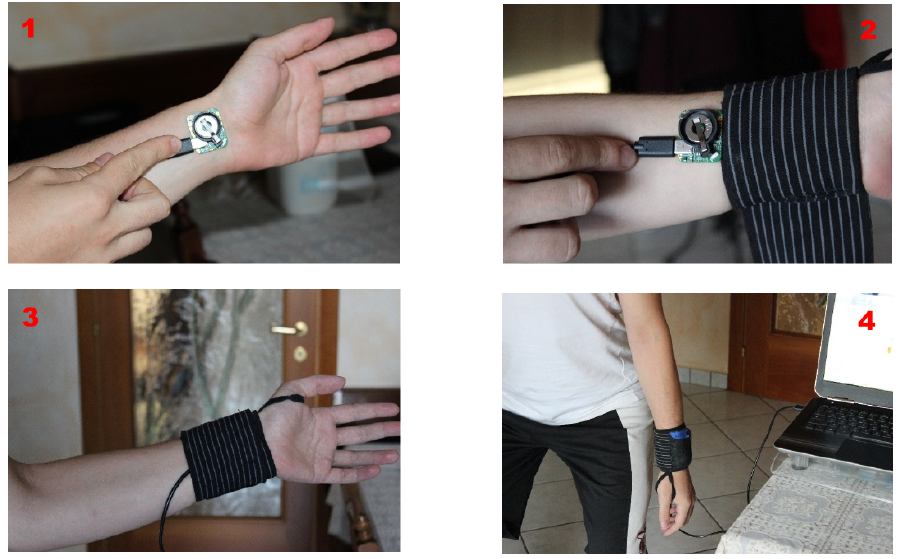
Figure 4. PPG measurement set-up: ( 1 ) reference point for the positioning of the sensor; ( 2 , 3 ) insertion of the device inside the appropriate band; ( 4 ) preparation for a measurement